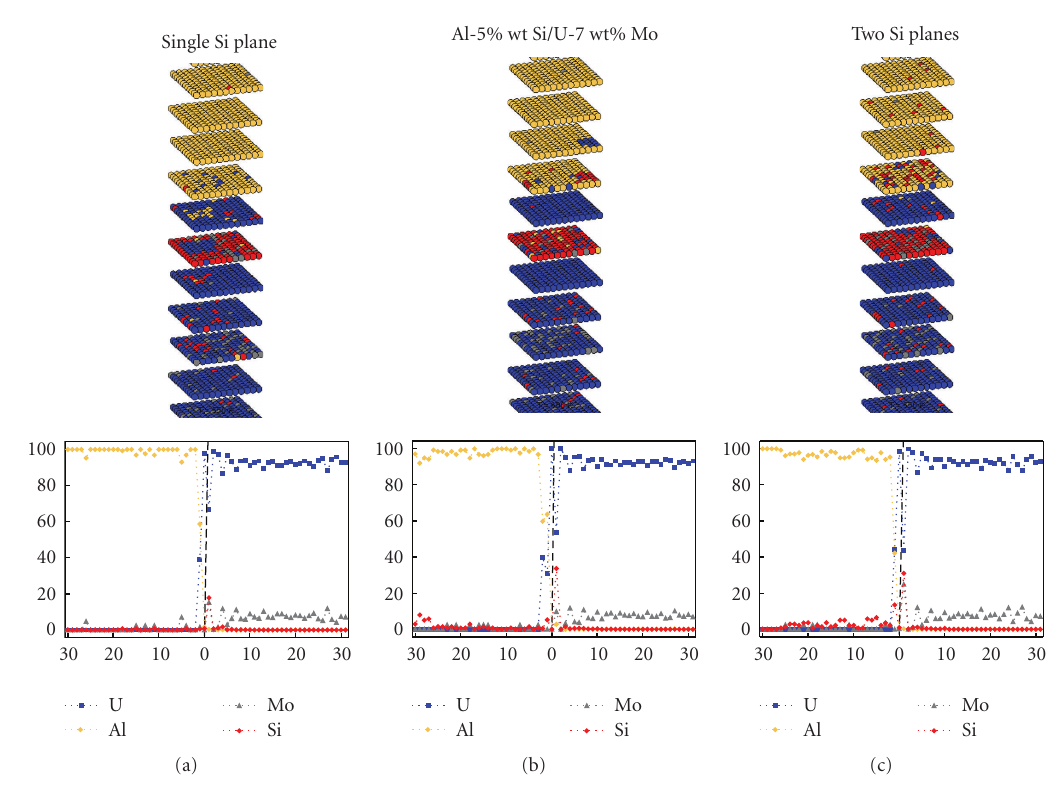
Figure 9: Monte Carlo simulation results for T = 450 K for (a) a single Si coating plane, (b) the usually accepted Al-5wt% Si/U-7 wt% Mo case, and (c) two Si coating planes, and their corresponding concentration profiles (in wt%). U, Mo, Al, and Si atoms are denoted with blue, grey, yellow, and red spheres (cells) or lines (profiles). The original location of the interface (at the onset of the simulation) corresponds to the label “0”.